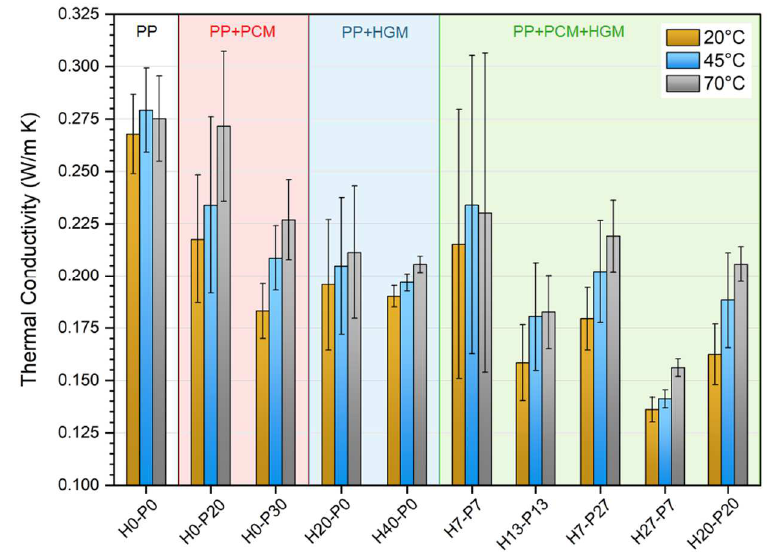
Figure 8. Thermal conductivity values of the prepared foams from LFA